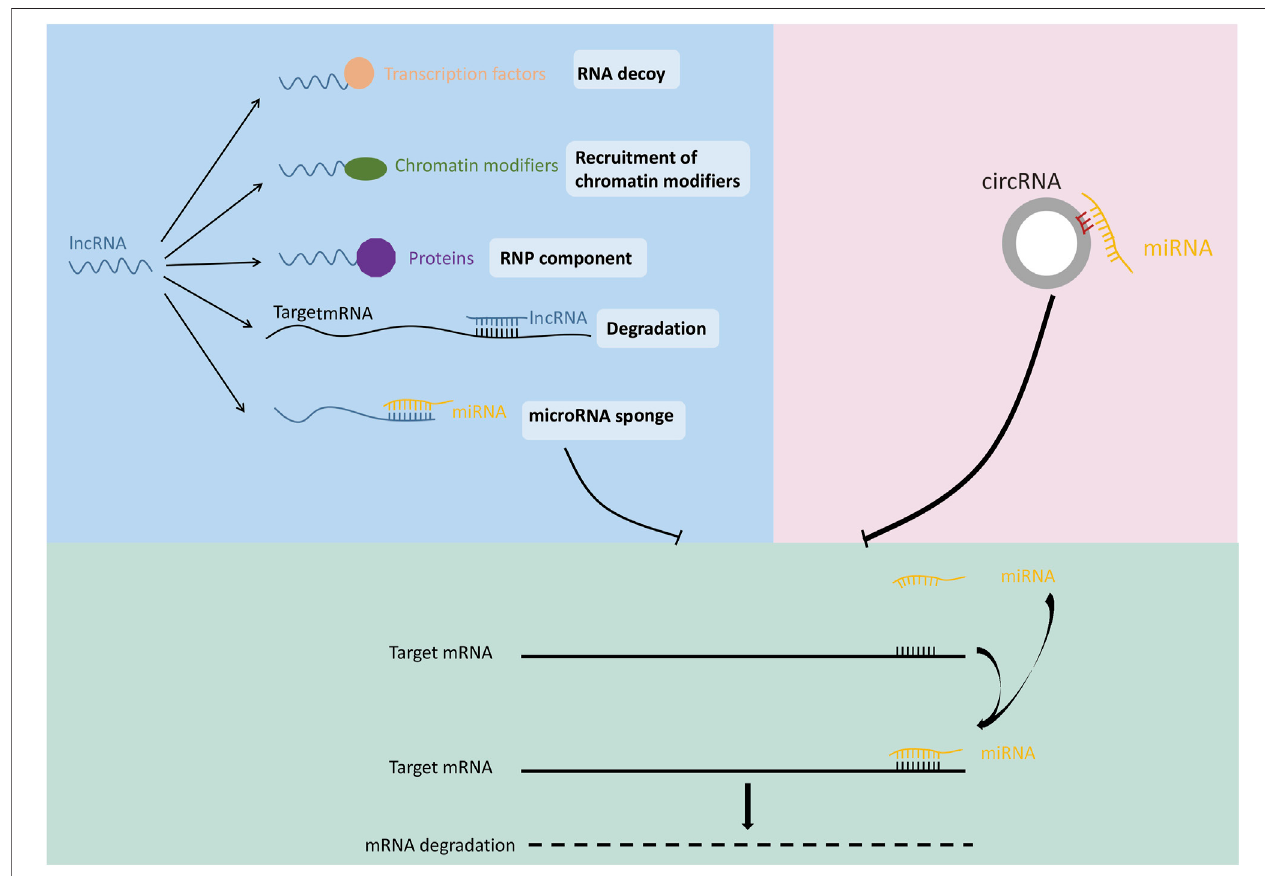
FIGURE 2 | Mechanisms of ncRNA